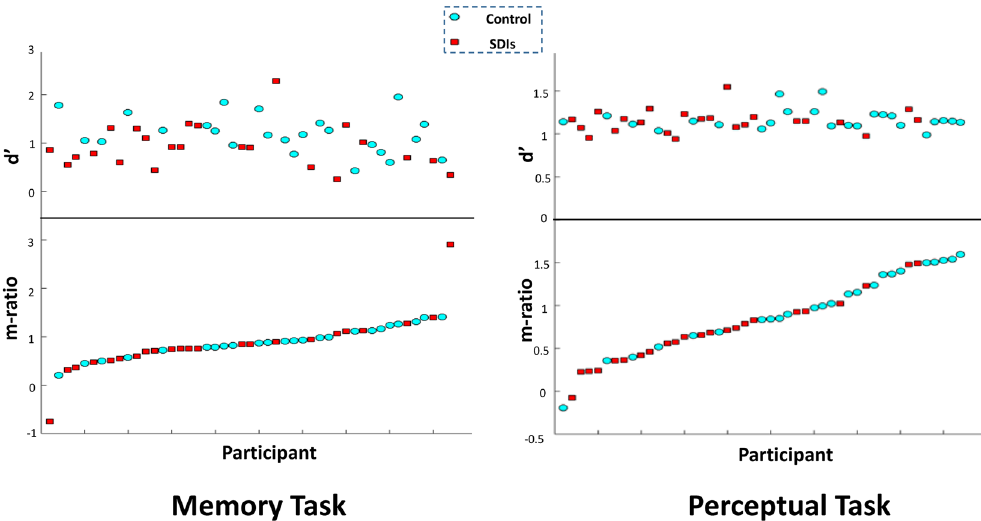
Figure 1. Metacognition (m-ratio) and type 1 performance (d ′ ) in memory (left) and perceptual (right) tasks. The 47 participants (24 Control + 23 SDI) are sorted by their m-ratio in